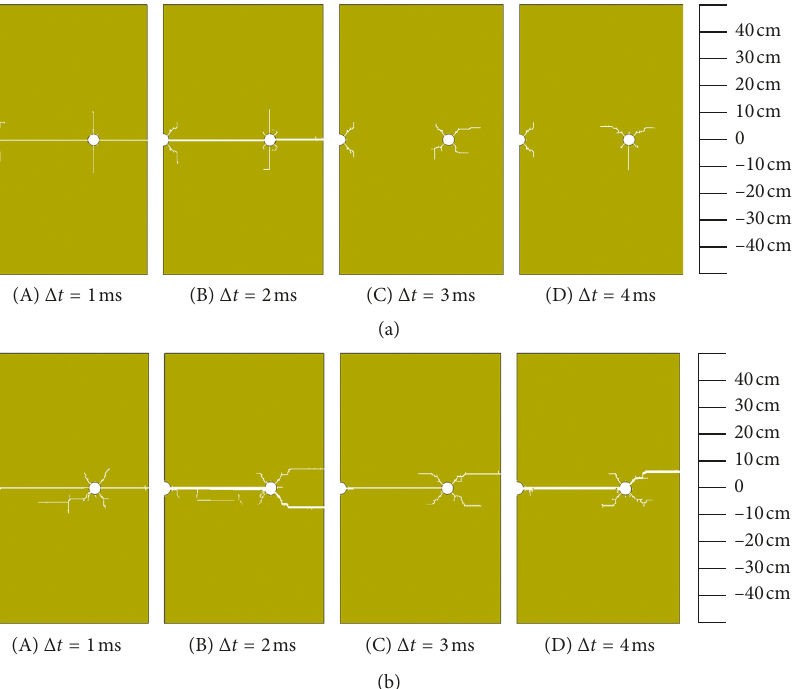
Figure 15: Crack formation diagram under different PBH shapes and different delay time. (a) The PBH is a round hole. (b) The PBH is a notch hole.